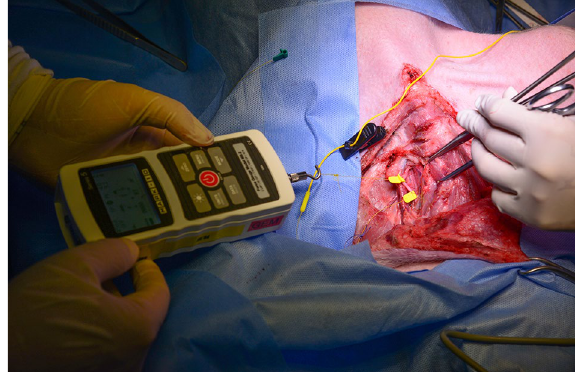
Figure 1. Illustration of the tensile test. The parameters and threshold levels of the VN were recorded using APS and a hand-held tensile testing system before the probe displacement test.